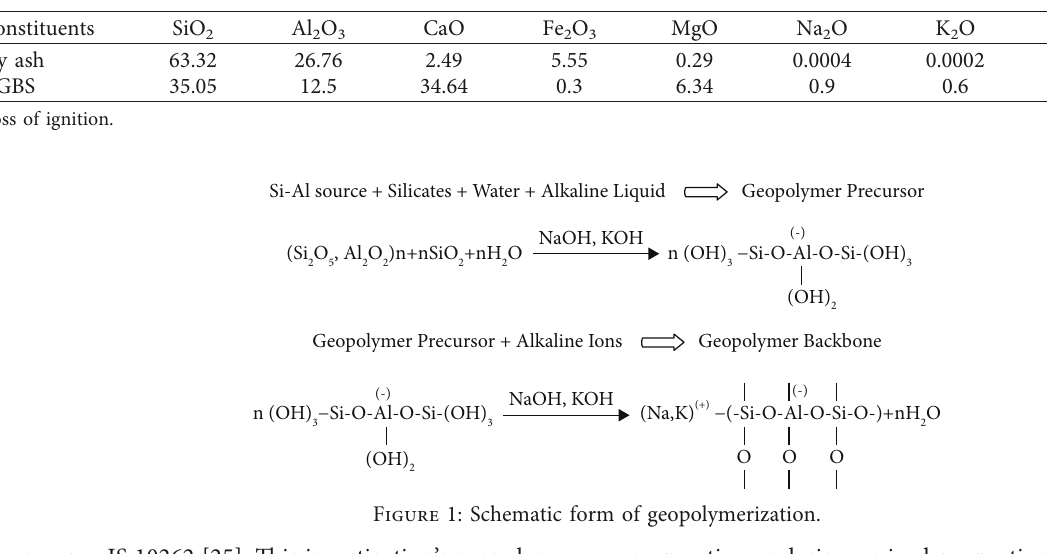
Table 1: Chemical constitution (in %) of fly ash and GGBS.